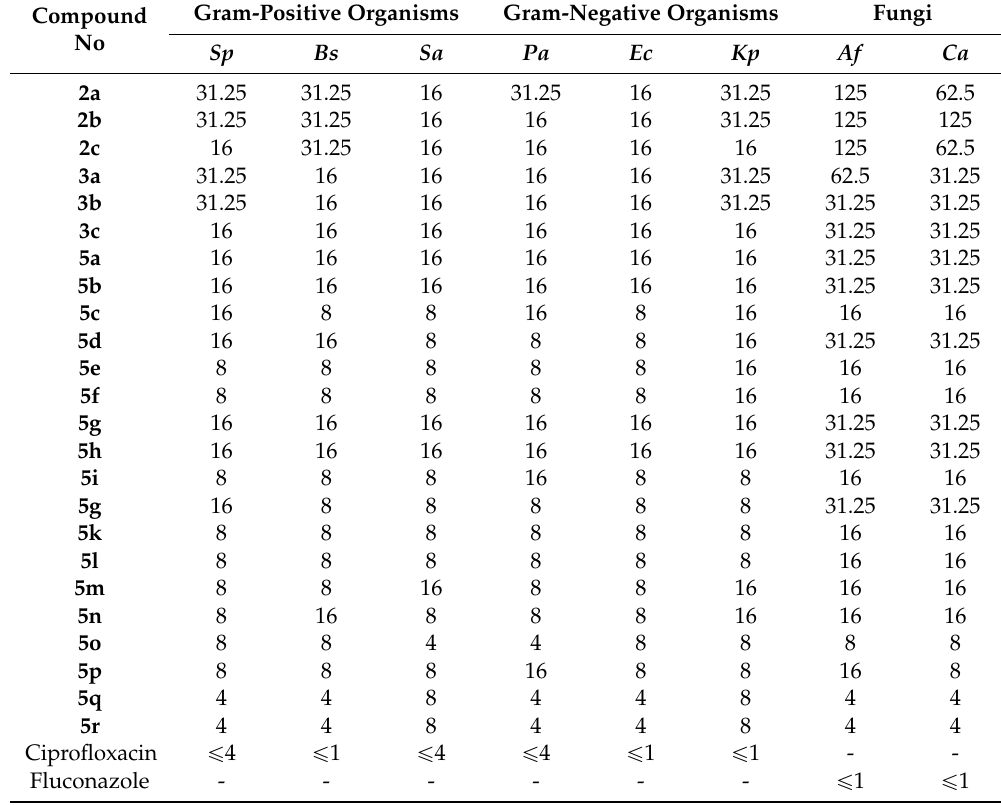
Table 3. Antimicrobial activity expressed as Minimum Inhibition Concentration (MIC, µ